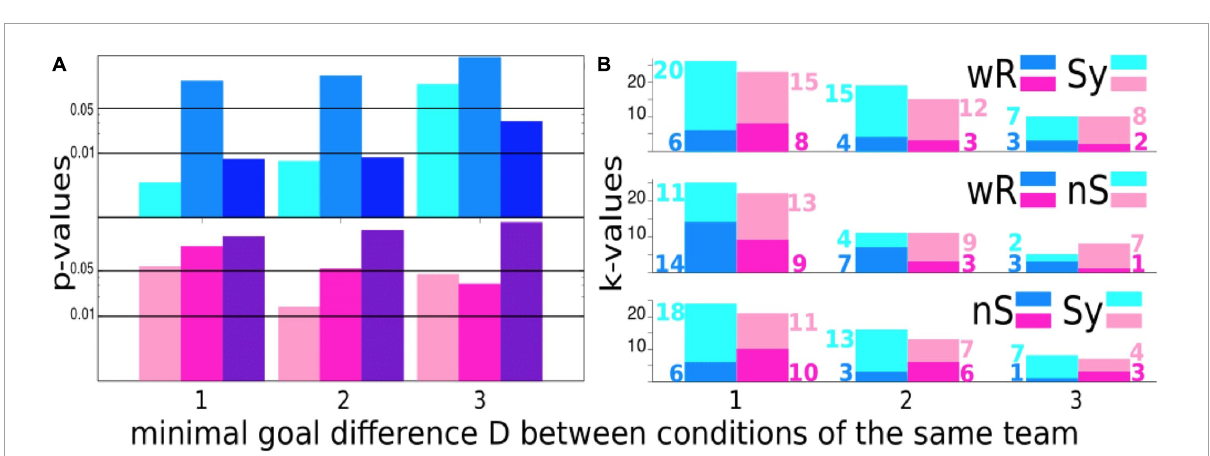
FIGURE3 (A) Probabilities that the scoring differences D of a team playing under different conditions occur by chance according to the binomial distribution for the male (upper panel) and female teams (lower panel) on a logarithmic scale. We compare the setting without rhythmic stimulation (wR) with the synchronous displayed condition (Sy) (light pink/blue), wR- vs. the non-synchronous acoustic stimulation (nS-) condition (pink/blue) and the Sy-condition vs. nS-condition (dark pink/blue). Horizontal black lines indicate the 1 and 5% significance level. (B) Number of times where the scoring difference was in favor of one or the other condition. Each panel shows the comparison of two conditions for different values of the scoring difference D. Again, blue colors denote results for the male and pink colors for the female teams. The color code for the settings wR, Sy, and nS is indicated in the right border at each panel. wR = without rhythmic acoustic stimuli, Sy = rhythmic acoustic stimuli displayed collectively in a synchronous fashion at 140 bpm, nS = rhythmic acoustic stimuli displayed collectively but each player with another